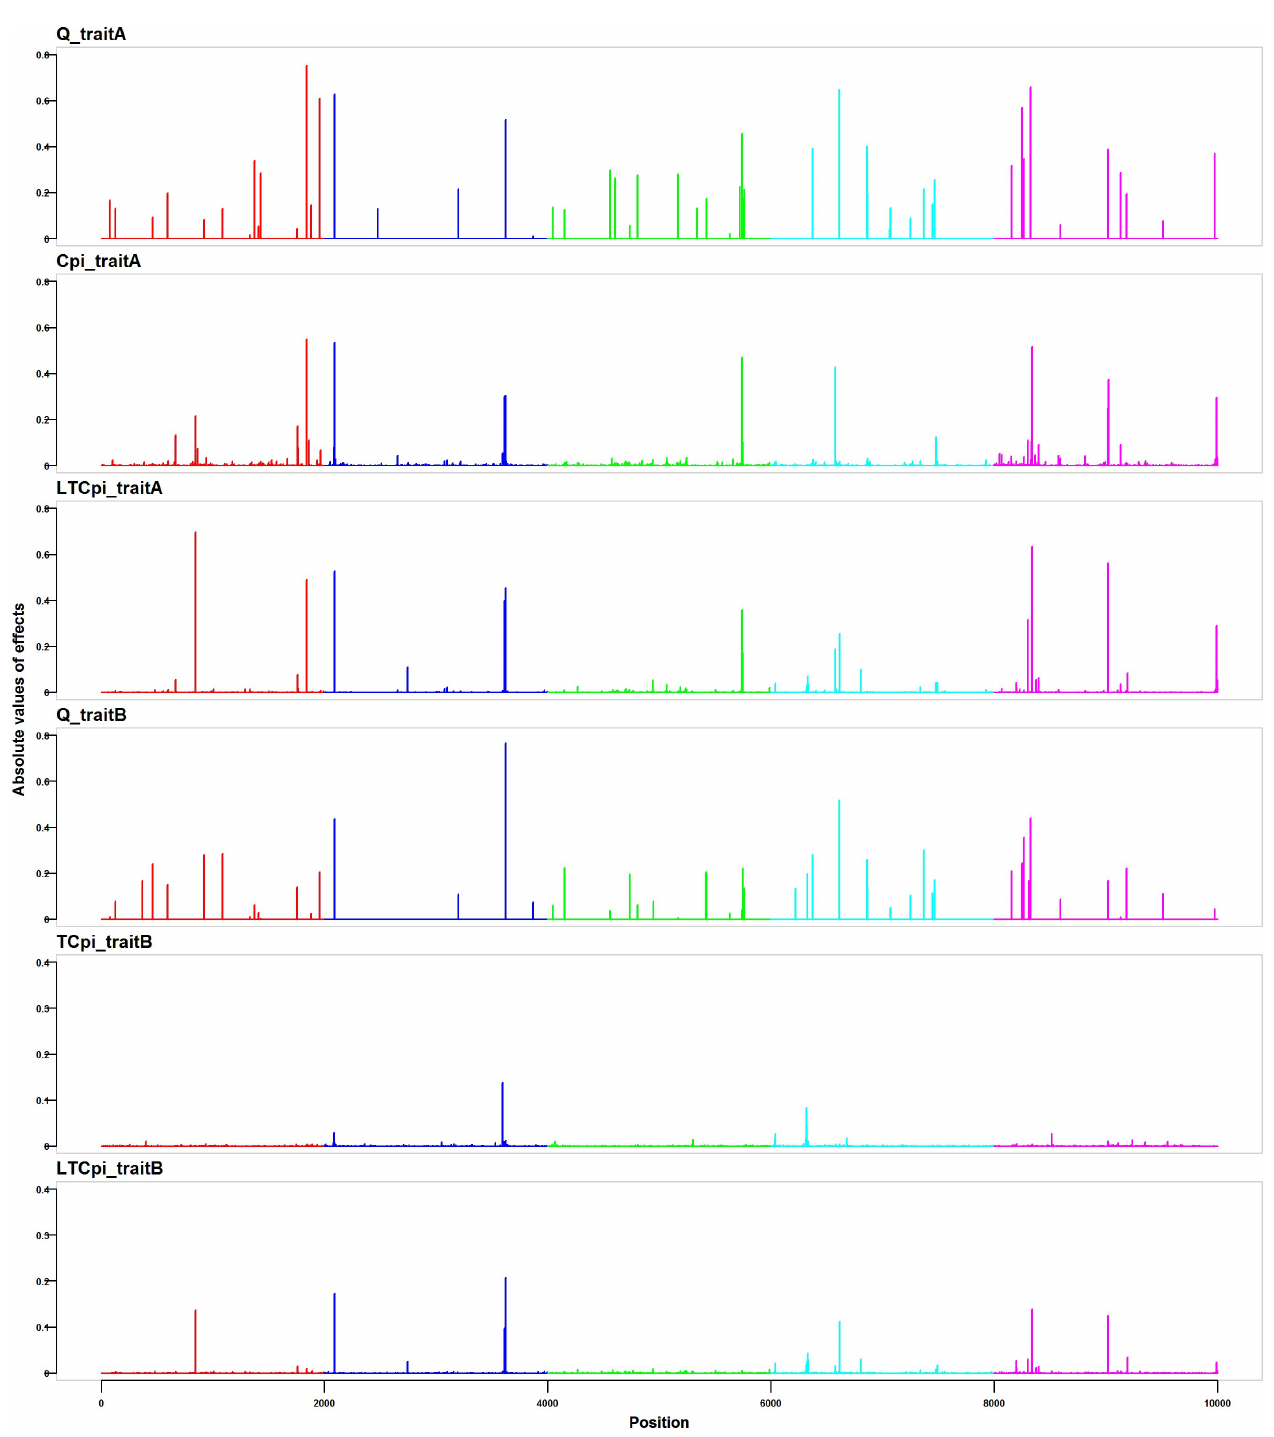
Fig 1. Simulated QTL effectsand estimated SNP effects for the continuous trait (trait A) and the binary threshold trait (trait B) from a randomly selected replicate in the standard scenario. Panels Q_traitA and Q_traitB show the absolutevalues of the simulatedtrue QTL effects. PanelsCpi_traitA, LTCpi_traitA, TCpi_traitB, and LTCpi_traitB show the absolute values of estimated SNP effects by BayesC π for trait A, LT-BayesC π for trait A, BayesTC π for trait B, and LT-BayesC π for trait B, respectively.